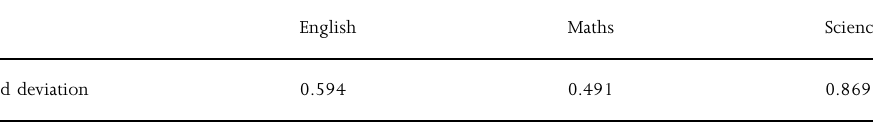
Table 8 School variability in subject